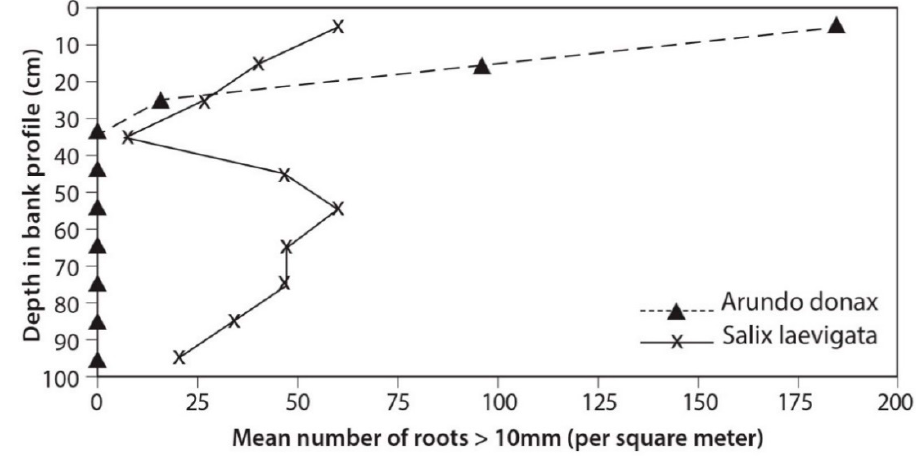
Figure 11. The mean number of roots greater than 10 mm in diameter (per square meter) for A. donax and S. laevigata. Table 8. Comparison of mean number of roots of different sizes at different depths for A. donax and S. laevigata.